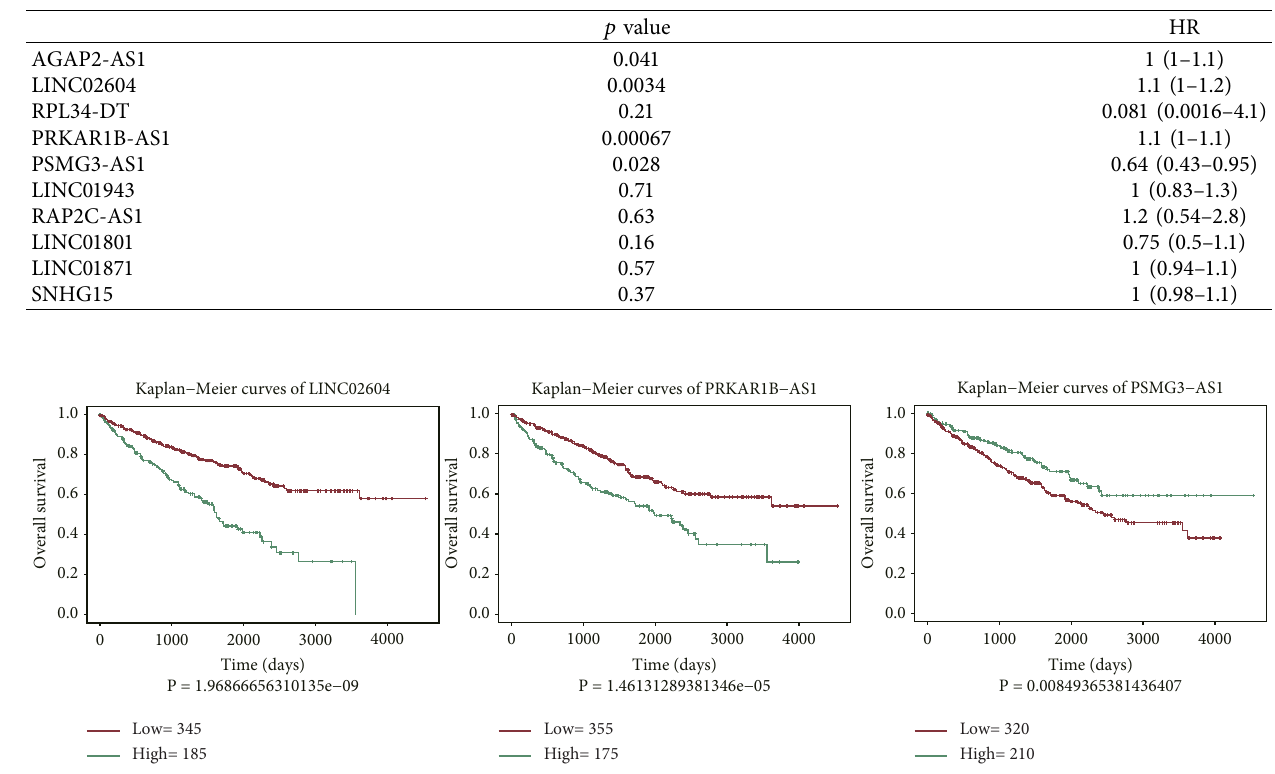
Table 1: Multivariate Cox regression analysis.